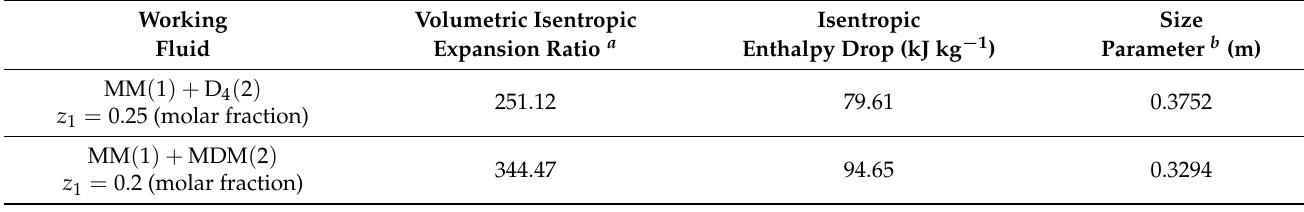
Table 6. Some turbine results. A comparison. Isentropic power one